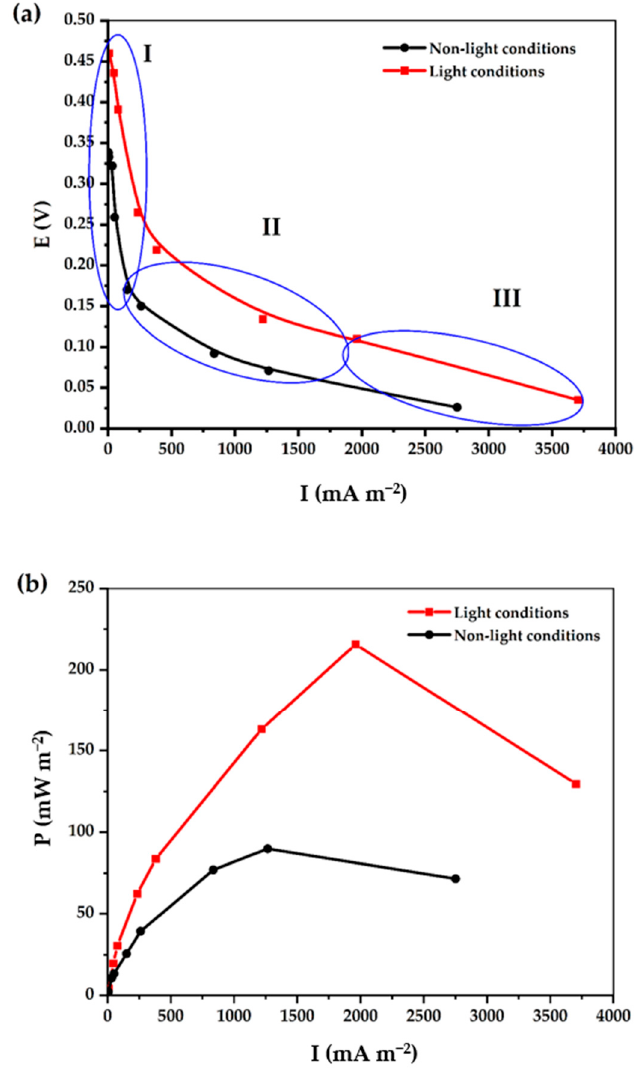
Figure 6. ( a ) Polarization curves and ( b ) power density for Li 0.95 Ta 0.76 Nb 0.19 Mg 0.15 O 3 -based MFCs. Table 1. Performance of MFCs equipped with the Li 0.95 Ta 0.76 Nb 0.19 Mg 0.15 O 3 cathode in the presence and absence of a light